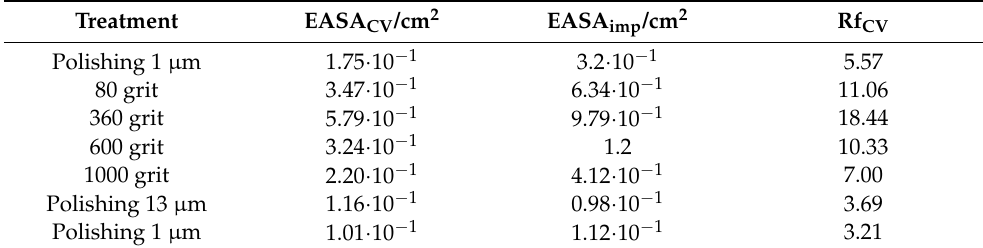
Table 1. Roughness factors Rf and EASA of the platinum surface ( A geom = 3.142 · 10 − 2 cm 2 ) mechani- cally roughened as obtained from impedance measurements and CVs.